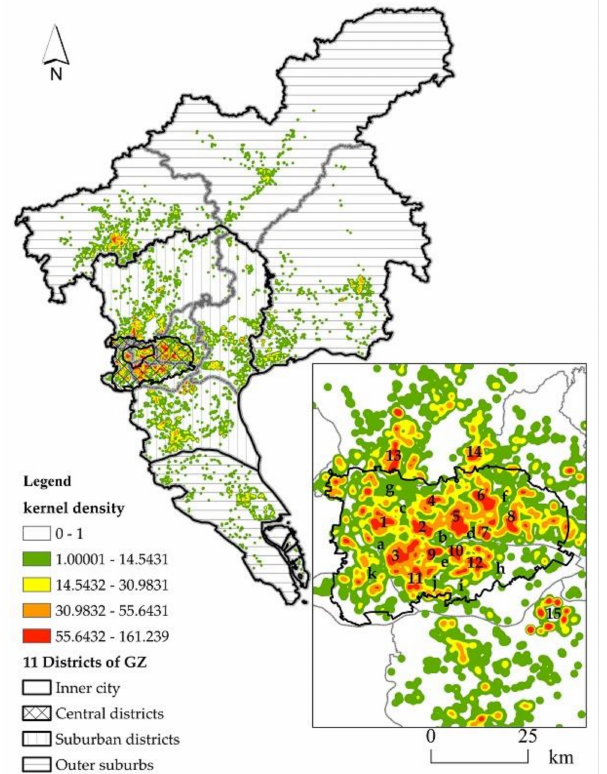
Figure 2. Map depicting the kernel density of Hive Boxes in Guangzhou. Note: 1 —Xi Guan; 2— Dongshan; 3—Long Daowei; 4—Xiao Bei; 5—Yang Ji; 6—Lin He; 7—Lie De; 8—Yuan Cun; 9—Su She; 10—Xia Du; 11—Wu Fengxiang; 12—Chi Gang; 13—San Yuanli; 14—Jing Xi; 15—Xiao Guwei; a—Shamian; b—Ersha Island; c—Zhongshan Fifth Road; d—Zhujiang New Town; e—Kangle Village; f—Wushan Nan Road; g—Zhannan Road; h—Shiliu Gang Road; i—Luntou Road; j—Ruibao Road; k—Huawan